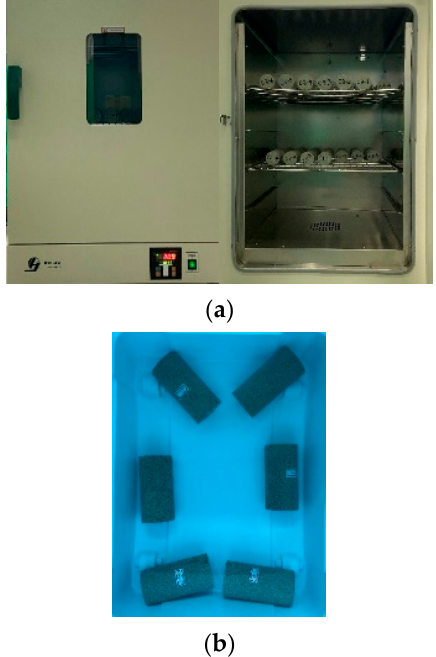
Figure 2. Specimen drying and immersion. ( a ) Drying. ( b ) Immersion.